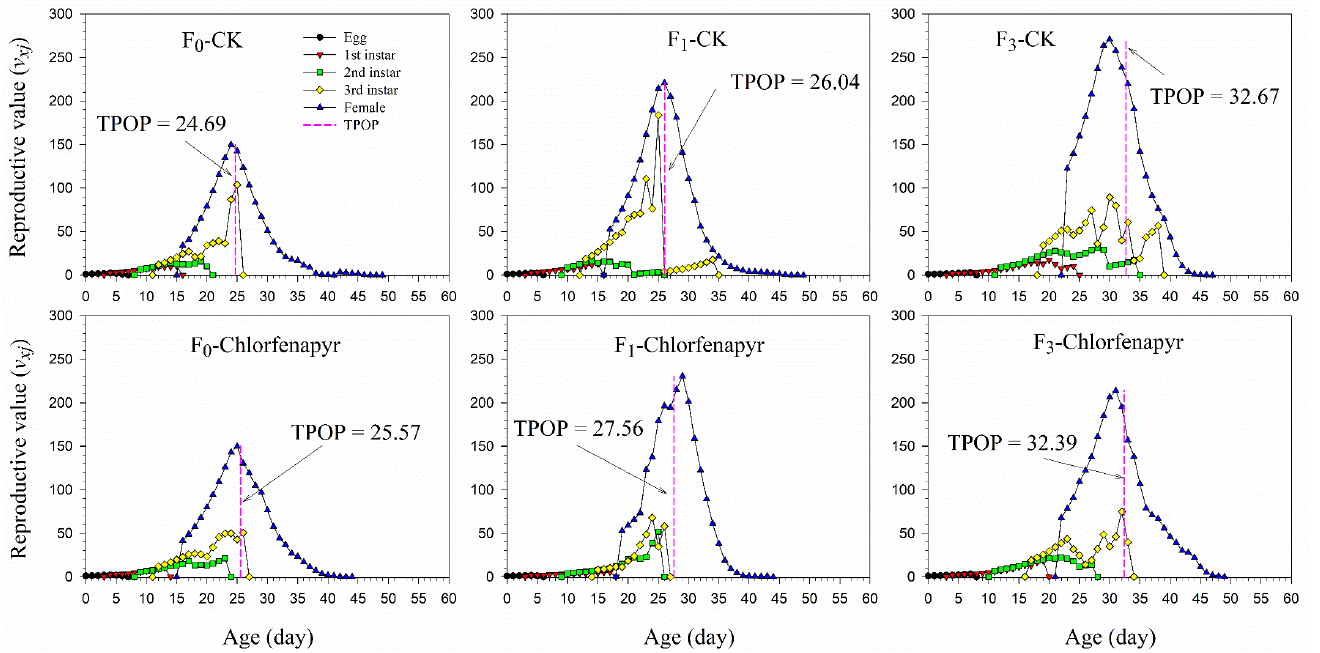
Figure 3. Age-stage-specific reproductive value ( v xj ) of P . marginatus (F 0 , F 1 , and F 3 ) exposed to LC 30 dose of chlorfenapyr. CK represents the control.